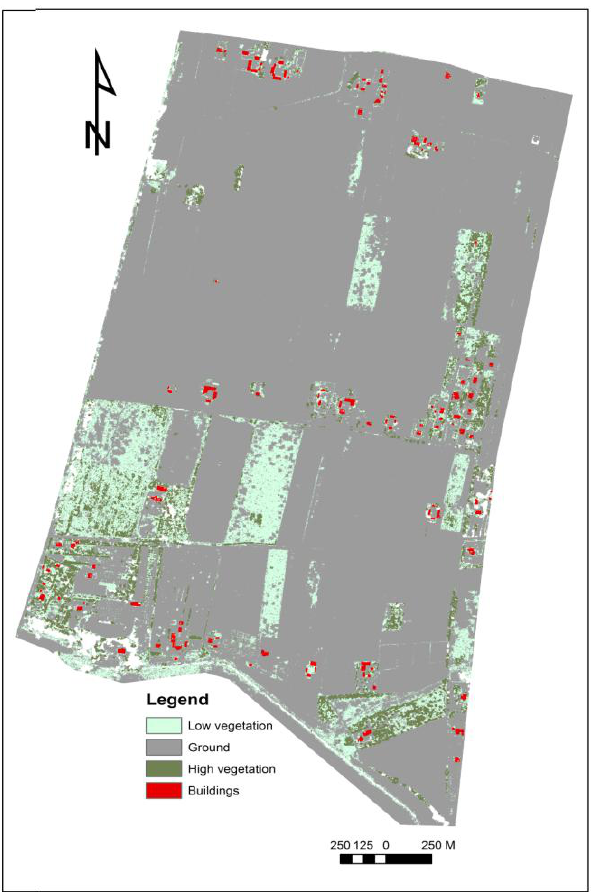
Figure. 2. Identification of areas excluded from